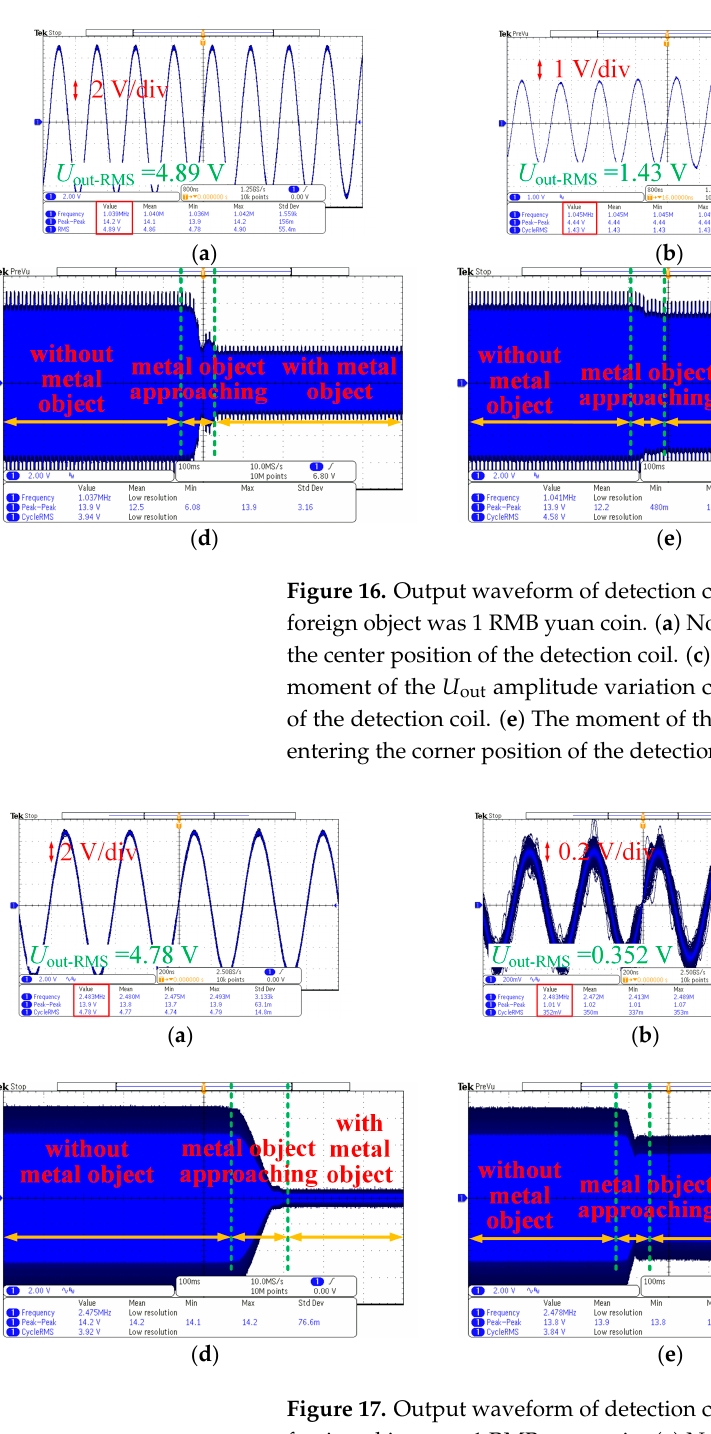
Figure 15. FOD experimental prototype based on the 3.3 kW wireless power transfer system. The detection results are shown in Figures 16–18.